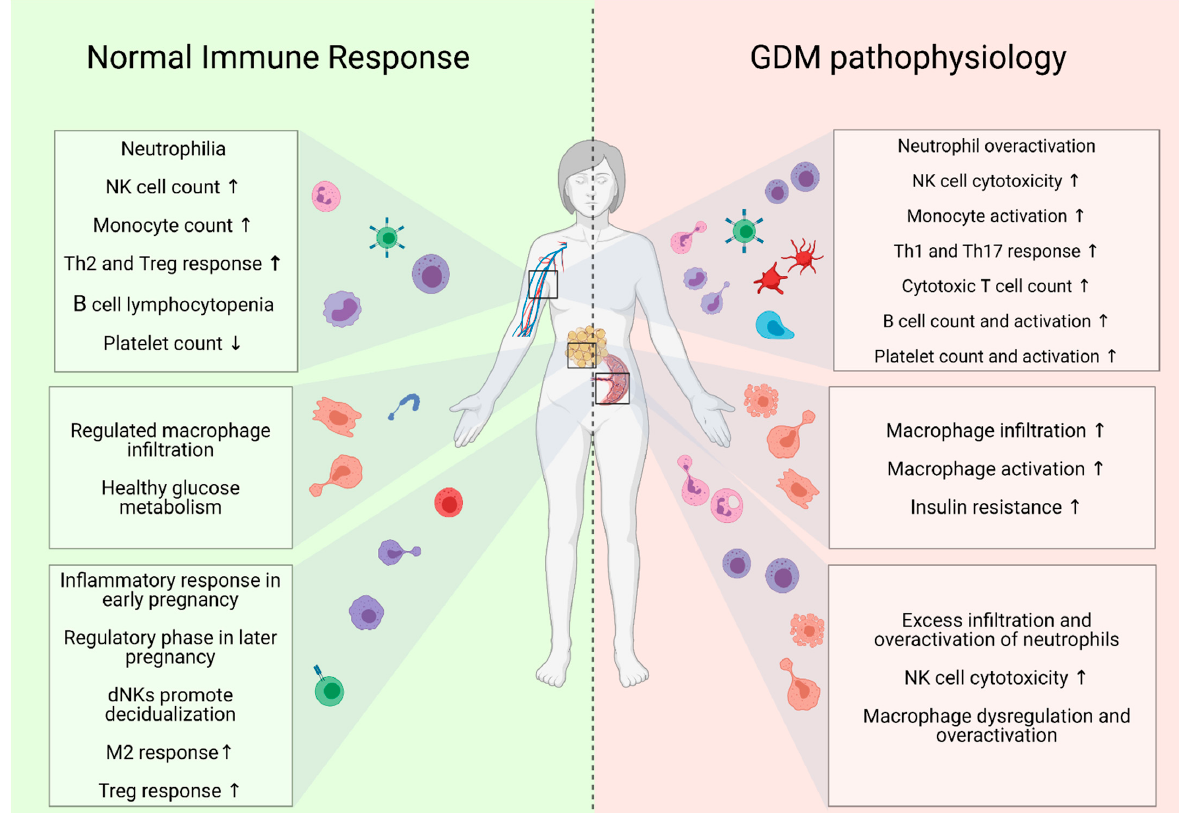
Figure 1. An overview characterising immune cell phenotypes in maternal circulation, adipose tissue and placental tissue in healthy uncomplicated pregnancy compared to pregnancy complicated by GDM. Created with Biorender.com. ↑ , increased; ↓ , decreased; GDM, gestational diabetes mellitus; NK, natural killer; Th2, T-helper 2 cell; Th1, T-helper 1 cell; Th17, T-helper 17 cell; Treg, regulatory T cell; dNK, decidual NK cell.